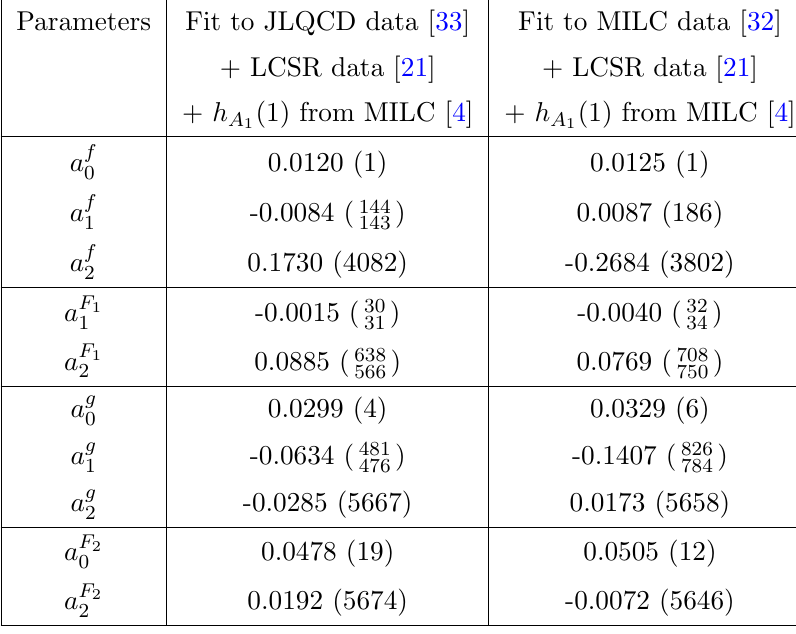
Table 11. The values of the BGL coe(cid:14)cients (N=2) extracted using the preliminary lattice results on form-factors beyond zero-recoil from MILC collaboration [32] and JLQCD [33]. In both the analyses, LCSR inputs [21] for q 2 = 0 are used and h A Fermilab/MILC lattice data